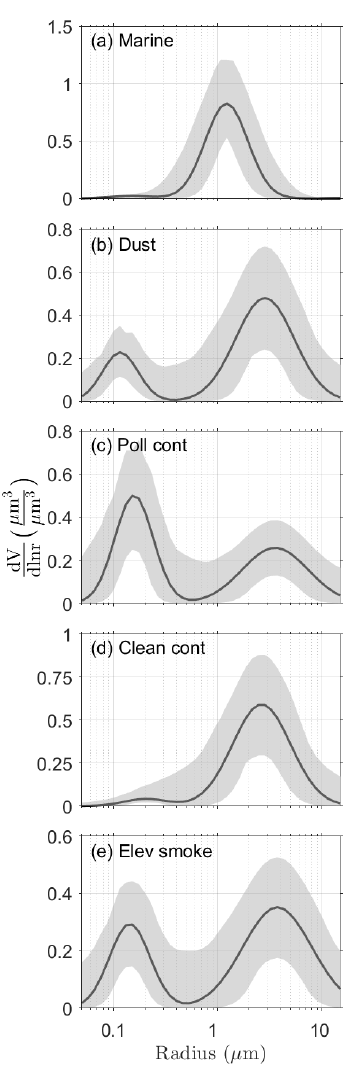
Figure 3. Normalized bimodal log-normal volume size distributions for marine (a) , dust (b) , polluted continental (c) , clean continen- tal (d) , and elevated smoke (e) aerosol subtypes adopted from the CALIPSO aerosol model. The shaded region represents the input space along with the maximum and minimum limits of size distri- butions selected for the sensitivity analysis.